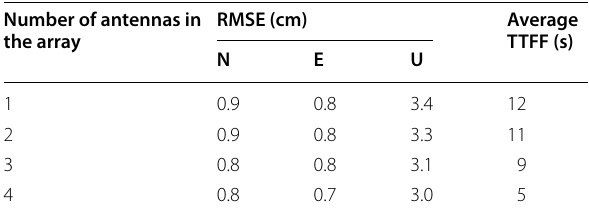
Table 6 Empirical RMSE in North, East and Up components and average TTFF Number of antennas in the array